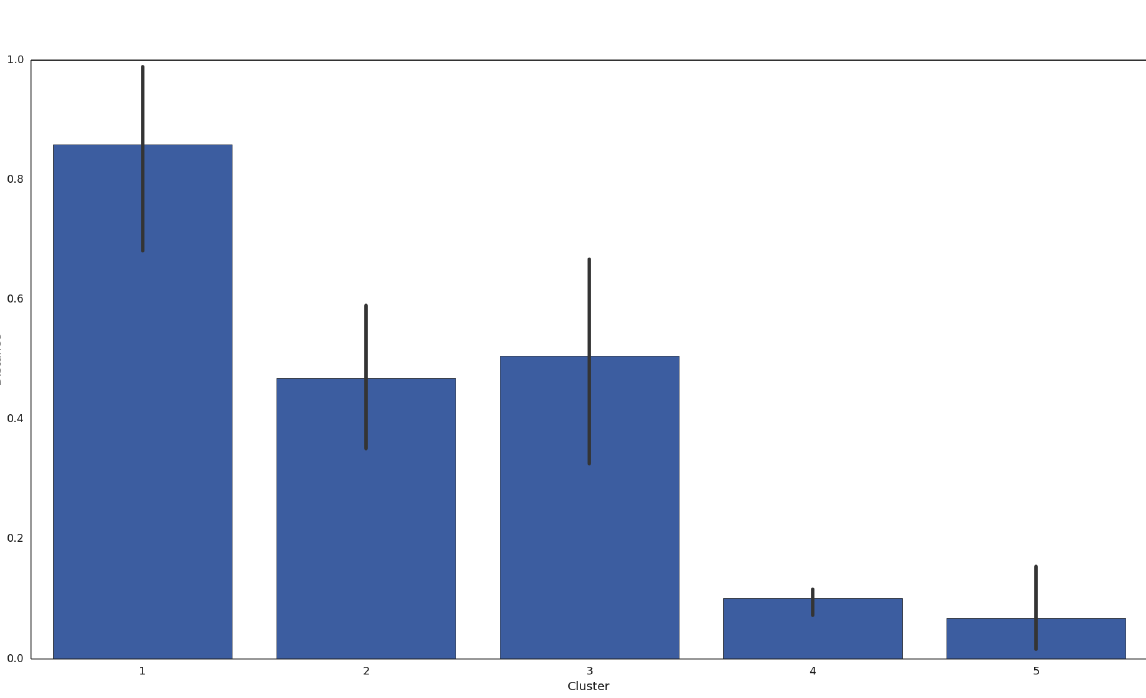
Fig 6. Jensen-Shannon Matrix. Note the large divergence between Clusters 1 and 4, both high marital satisfaction clusters.